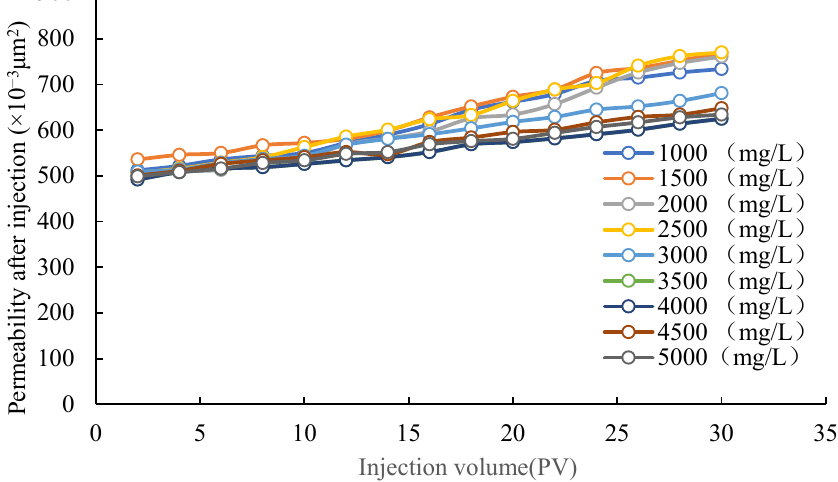
Figure 7. Permeability changes with the injection volume of distilled water.